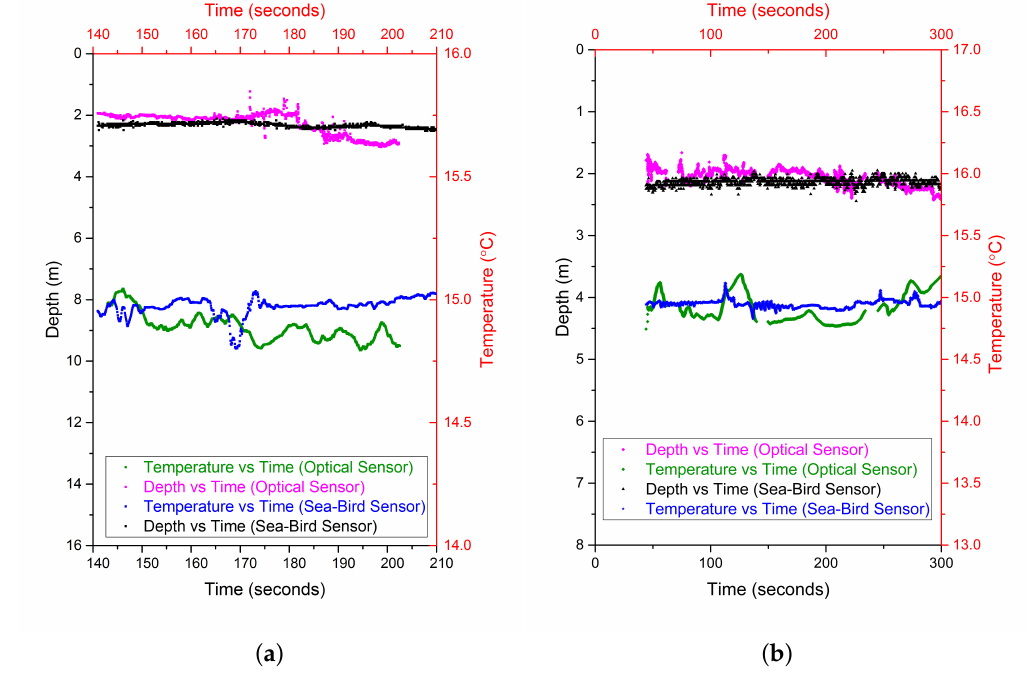
Figure 7. Depth, Temperature response vs time in comparison to the reference sensor ( a ) Deployment station NMEA Latitude = 51 49.54 N, NMEA Longitude = 008 16.31 W ( b ) Deployment station NMEA Latitude = 51 49.67 N, NMEA Longitude = 008 16.37